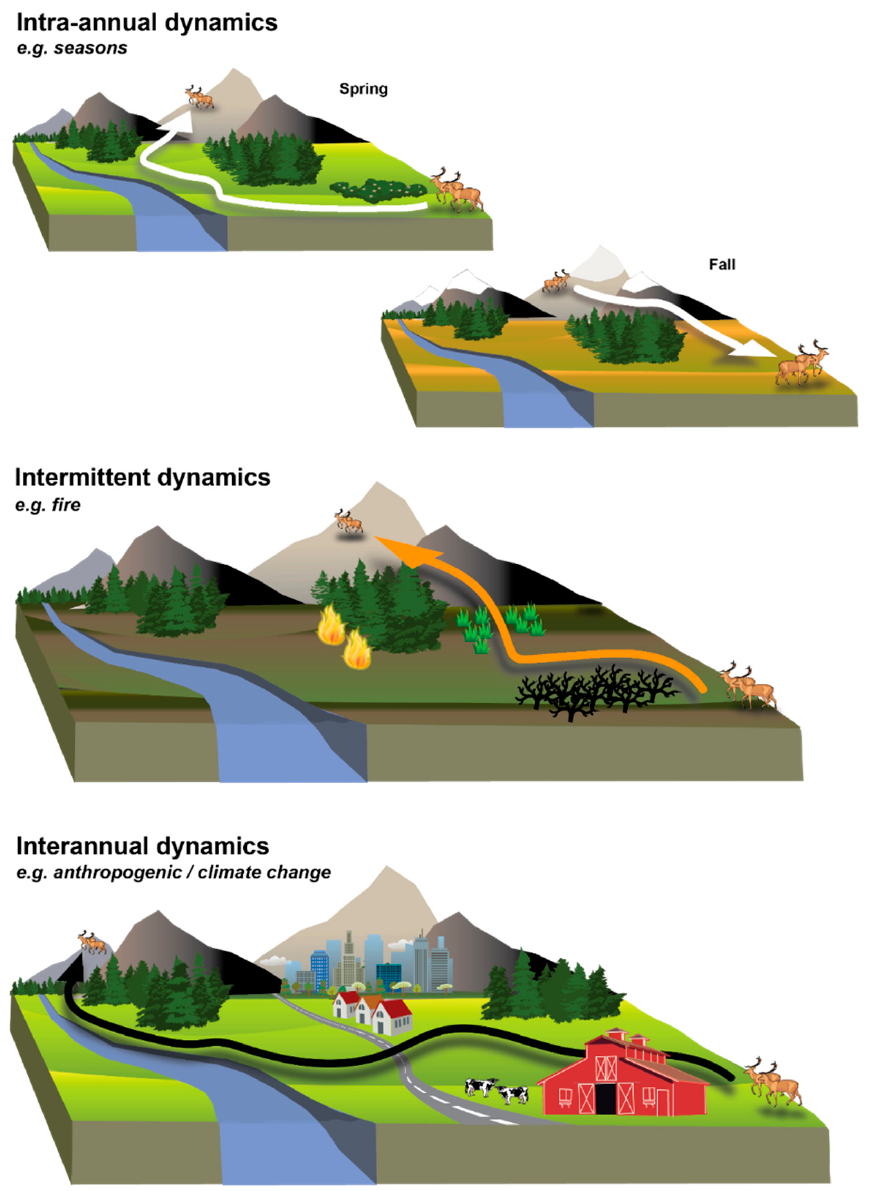
Figure 1. Examples of dynamic landscape connectivity. Figure represents dynamic connectivity (lines with arrows) for a migratory ungulate. The area of land that supports connectivity changes depending on intra-annual dynamics such as seasons, intermittent dynamics such as disturbance, and interannual dynamics such as anthropogenic development and climate change. This figure is an illustrative example of only a few dynamics discussed in the paper. Please see text for additional information.